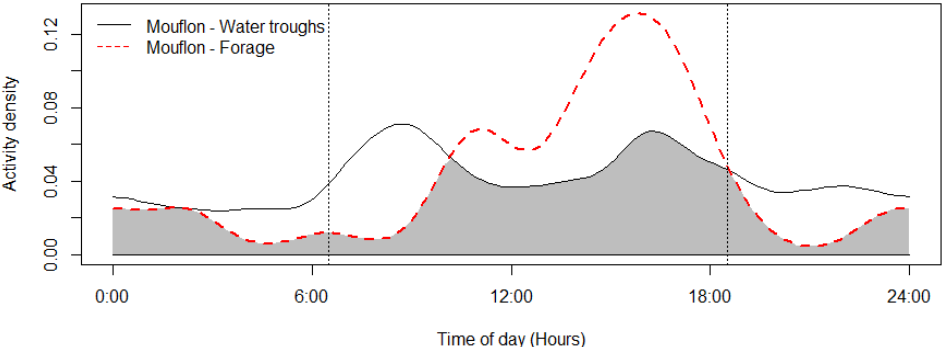
Figure 2. Mouflon activity overlap at monitored water troughs ( n = 10) and forage sites ( n = 5) (coefficient of overlap ∆ = 0.64). Sunrise and sunset are marked at their average time for the study period (gray zone shows the overlap area).